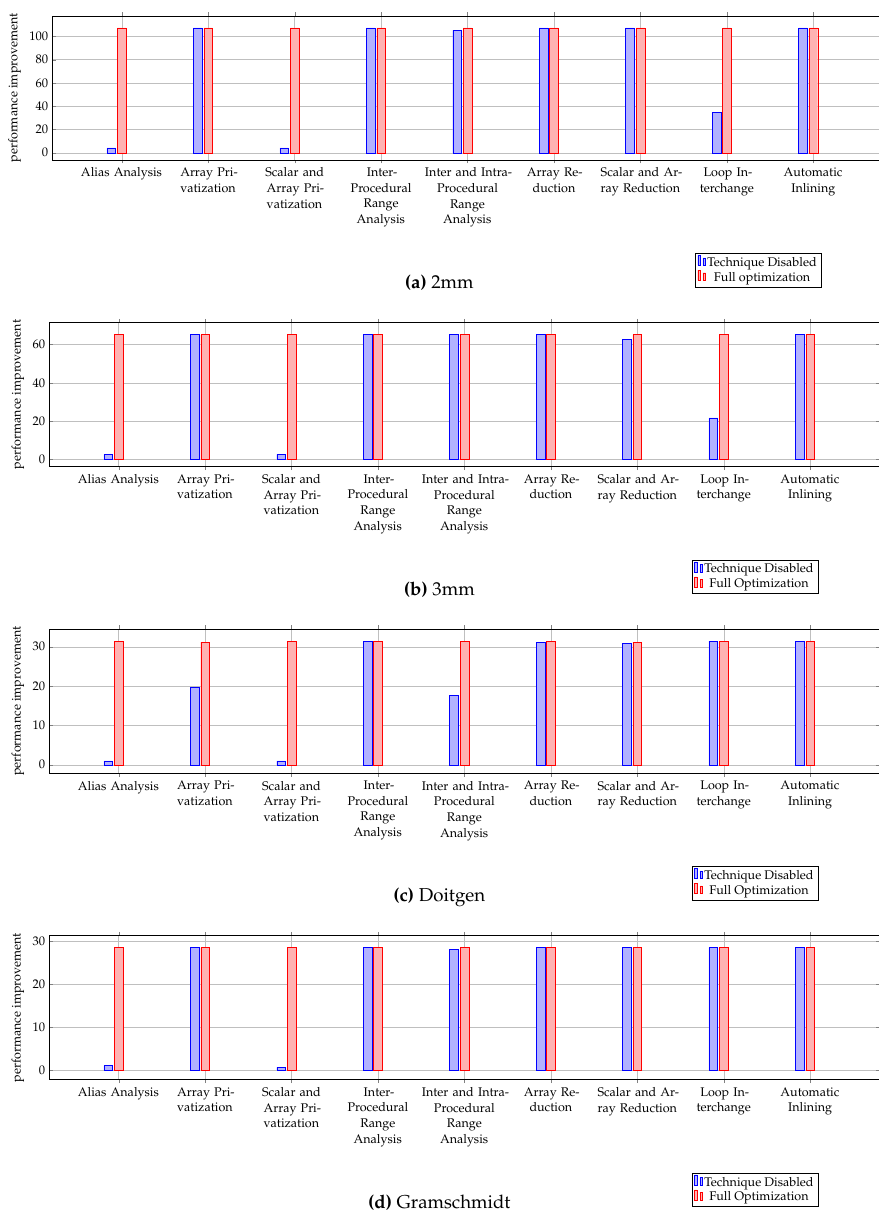
Figure 6. Performance results for 2mm, 3mm, Doitgen and Gramschmidt benchmarks from the PolyBench benchmark suite v4.2. The selected base case is the best tuned version (all on). One technique at a time is turned OFF and the impact on performance is plotted (Lower bar means a higher impact of the